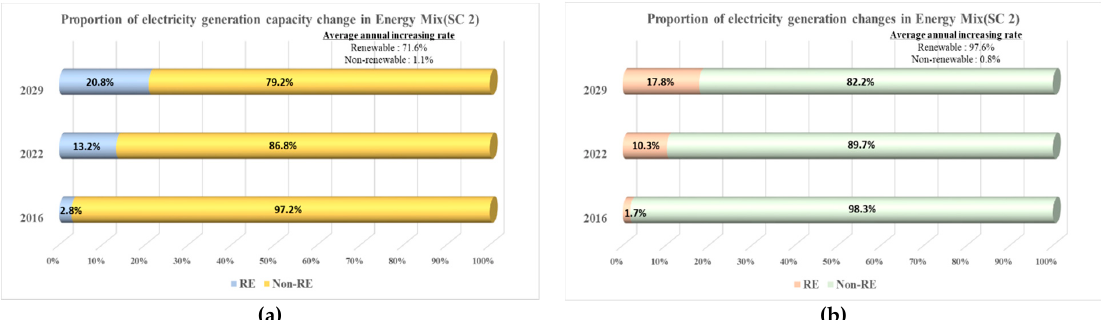
Figure 11. The proportion of RE / NRE capacity and generation. ( a ) Trends in the proportion of RE / NRE capacity (SC2); ( b ) trends in the proportion of RE / NRE generation (SC2).